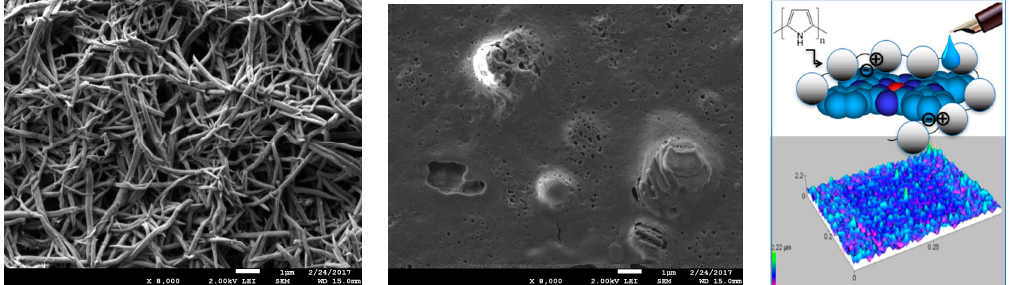
Figure 3. Schematic view of the ionic interactions between polypyrrole and cobalt sulfonated phthalocyanine and a topomicroscopic view of the hybrid material ( left ); SEM images of PTFA ( middle ) and PANI ( right ) electrodeposited on ITO.